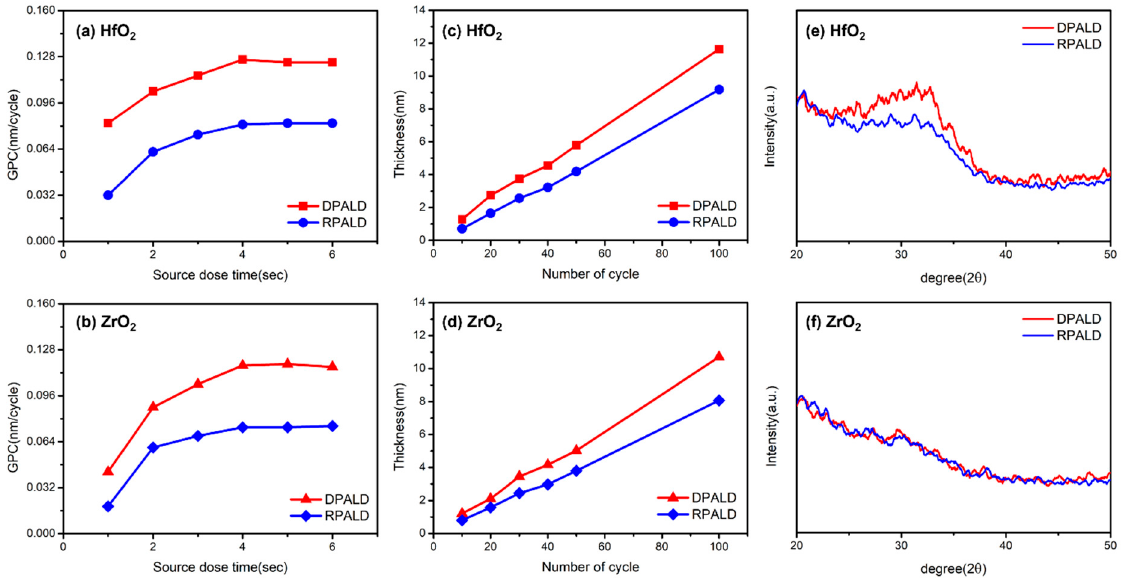
Figure 3. HfO 2 and ZrO 2 single thin films deposited by two PEALD methods: ( a , b ) GPC for the source time, ( c , d ) thickness according to the number of cycles, and ( e , f ) XRD patterns immediately after deposition.